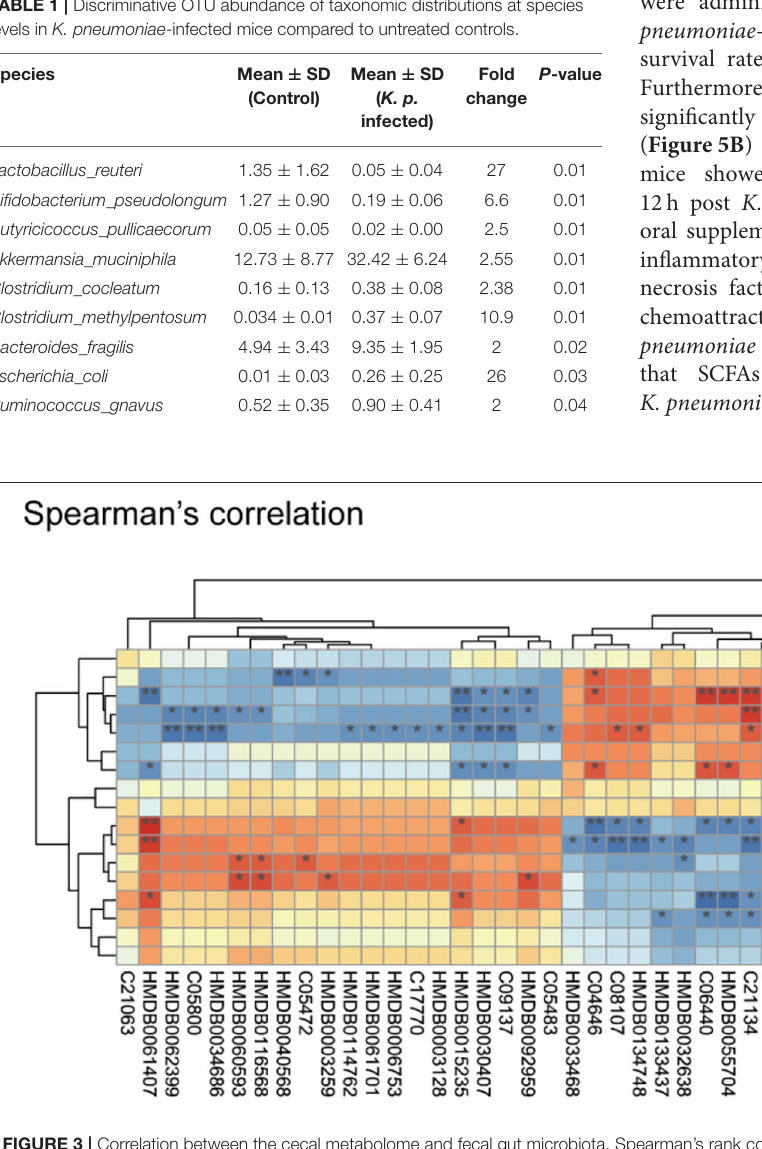
Frontiers in Immunology |